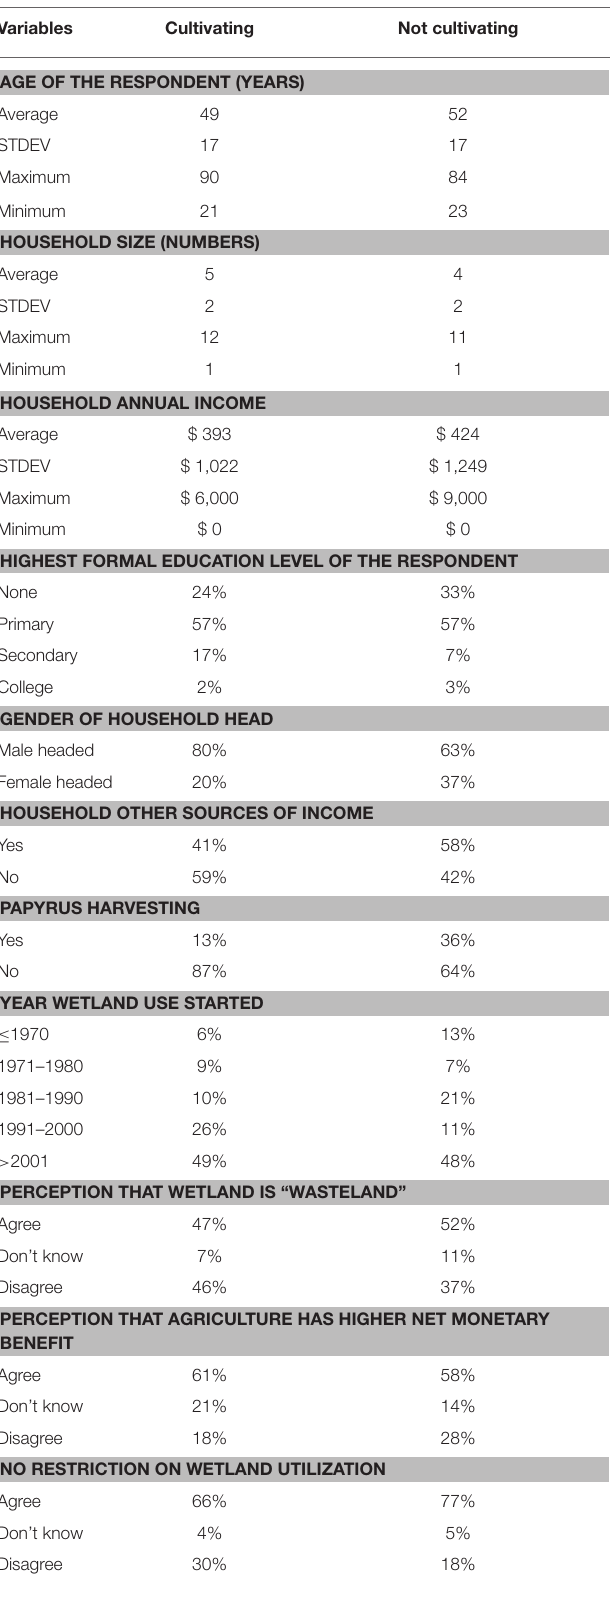
TABLE 4 | Descriptive statistics for selected variables between wetland cultivating and non-cultivating households. Variables